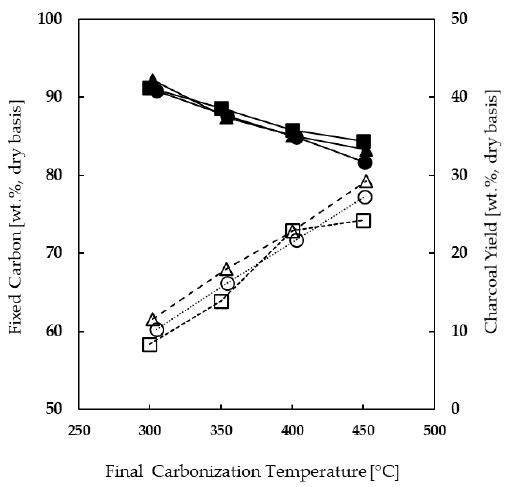
Figure 3. Charcoal’s fixed carbon content (open symbols, kg fixed carbon/kg dry charcoal) and yield (solid symbols, kg dry charcoal/kg dry wood) as a function of final carbonization temperature, during tests with holm oak (squares), cork oak (circles), and eucalyptus globulus (triangles), at 1 °C/min.